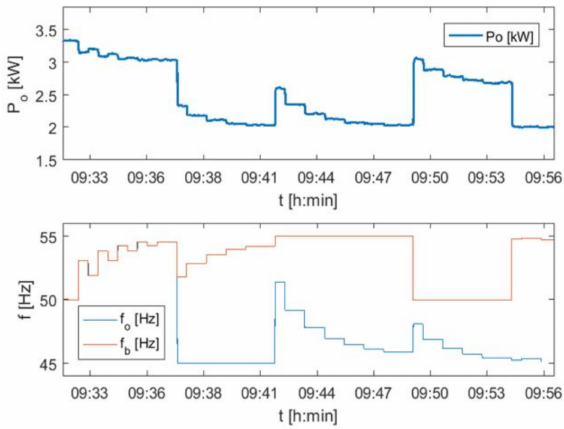
Figure 19. Example of optimization experiment (on-line optimization) for EMM D100. Symbols are the same as in Figure